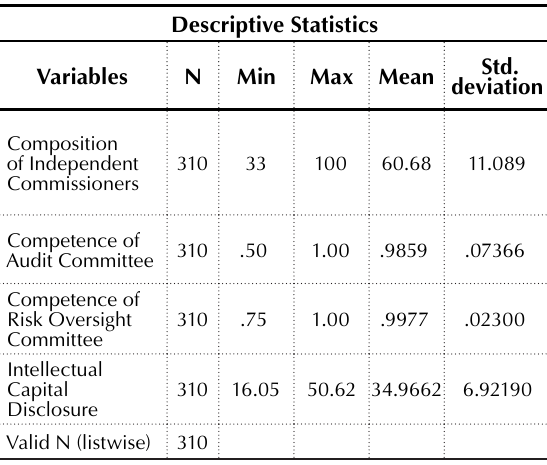
Table 2. Results of the descriptive statistic